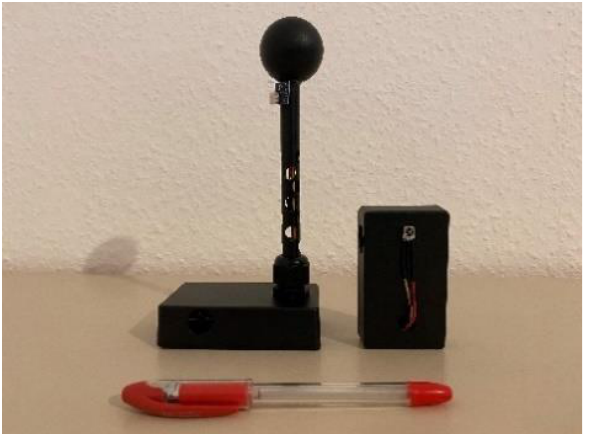
Figure 1. Comfort module (on the left side in the above picture); IR module (on the right side in the above picture). A ballpoint pen was placed in the front for scale.